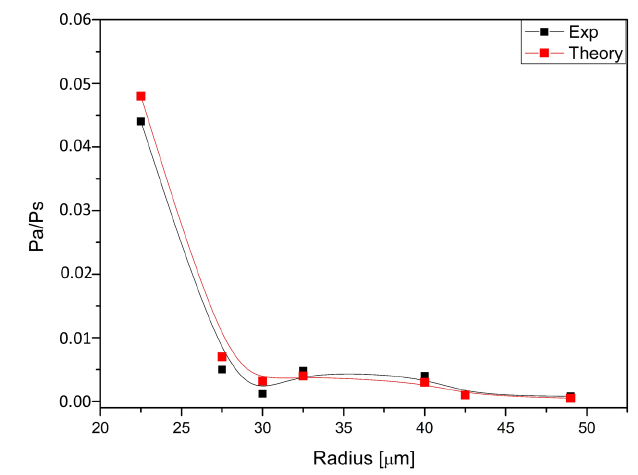
Figure 9. P a / P S ratio: experimental (solid black squares) and calculated values (solid red circles) The lines are a guide to the